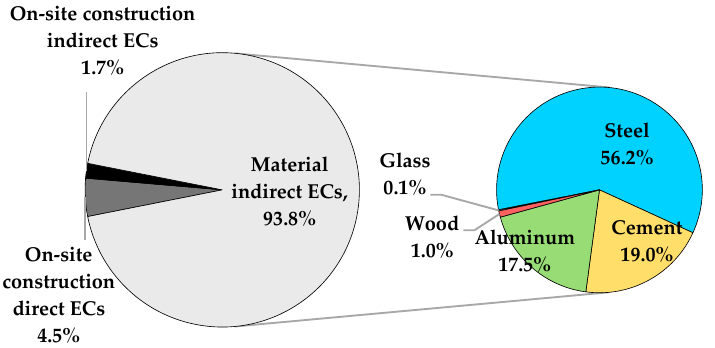
Figure 10. The composition of China’s building embodied carbon emissions (2020).